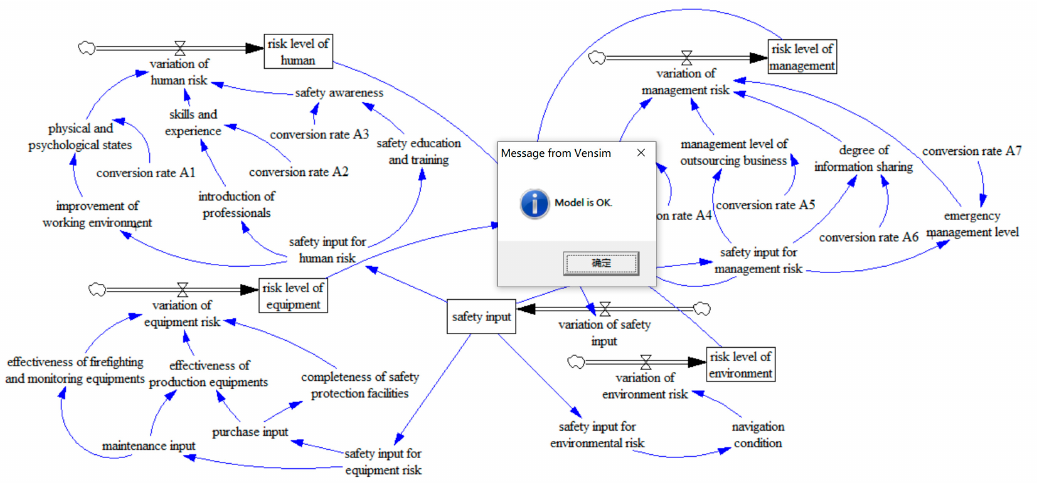
Figure 4. Diagram of model test.